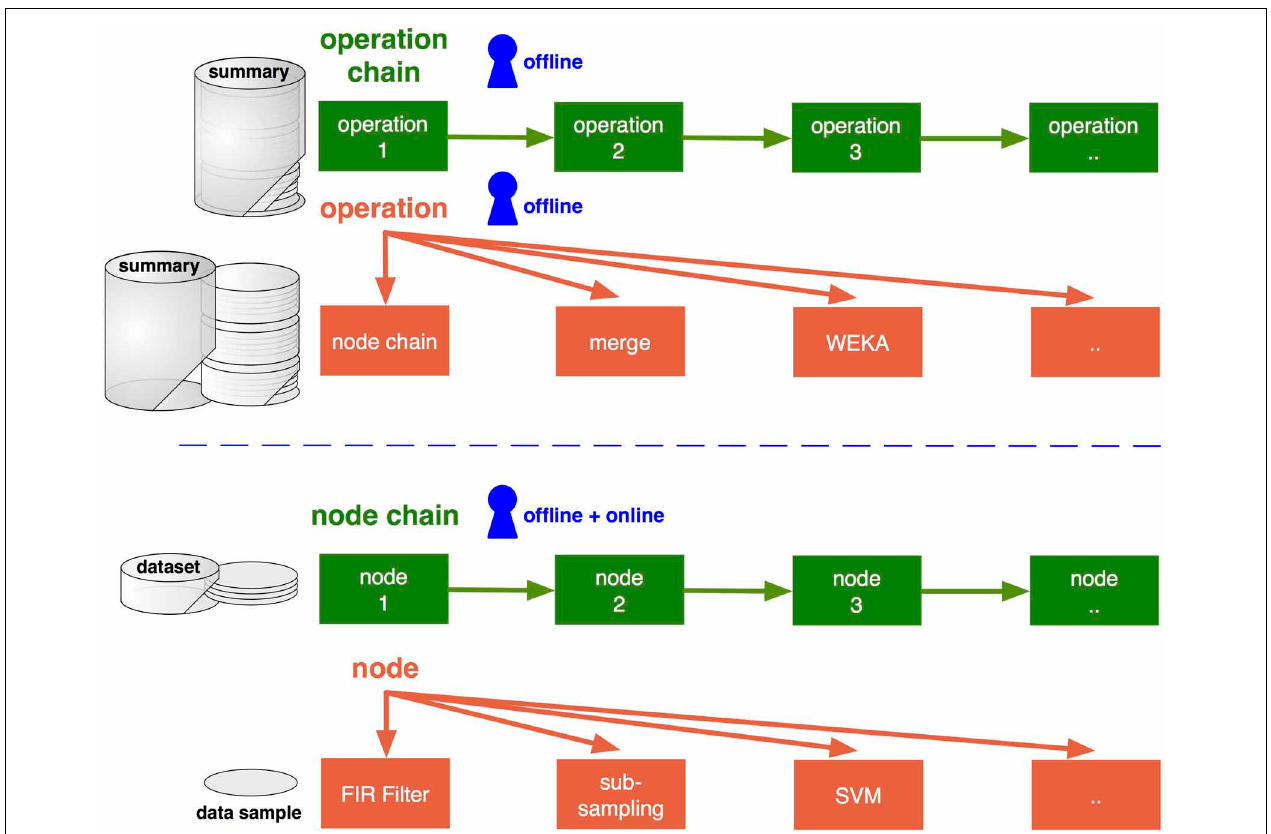
FIGURE 1 | High-level and low-level processing types (upper and lower part) and their connection to the data granularity (summary, dataset, sample). Access levels for the user are depicted in blue and can be specified with YAML files (section 3.2). Only low-level processing can be performed